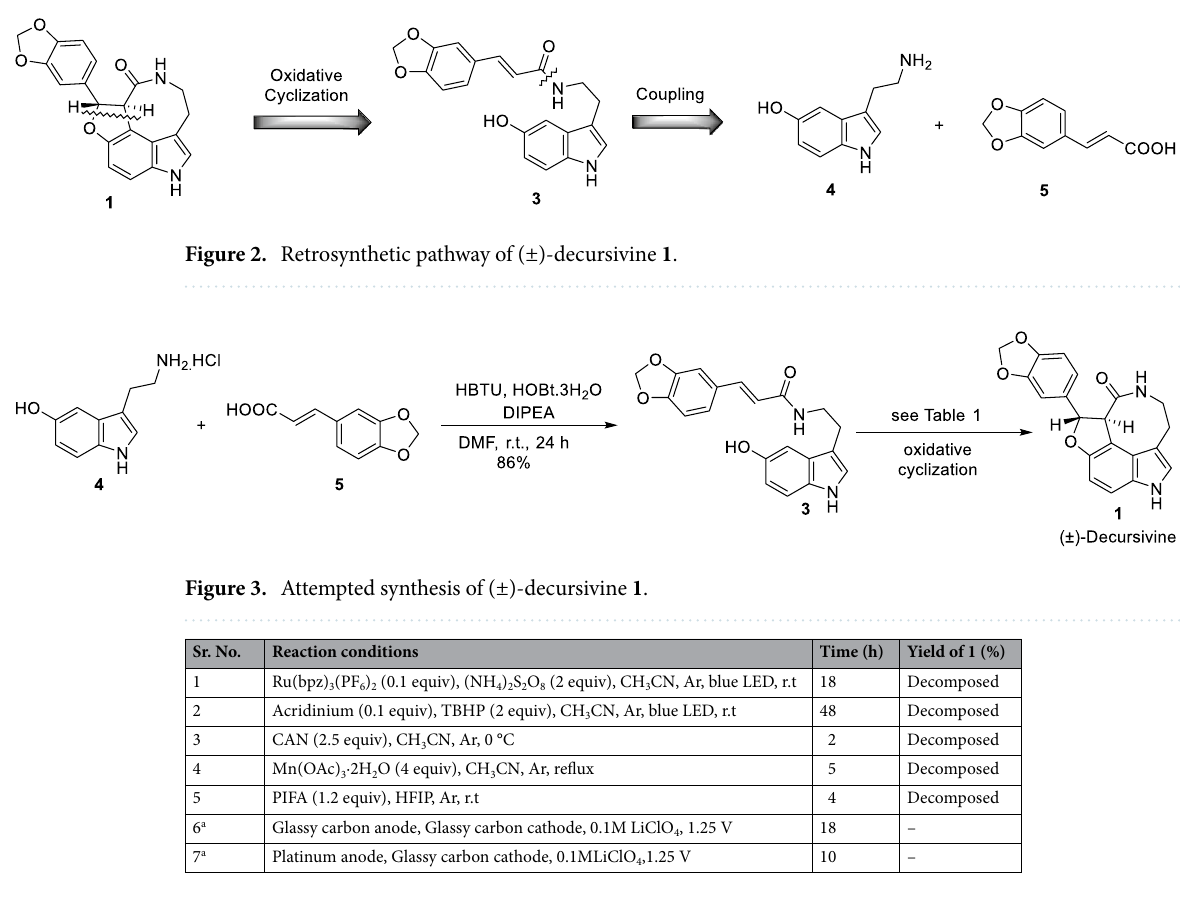
Table 1. Tandem oxidative cyclization of compound 3 . a Passivation of electrode observed.